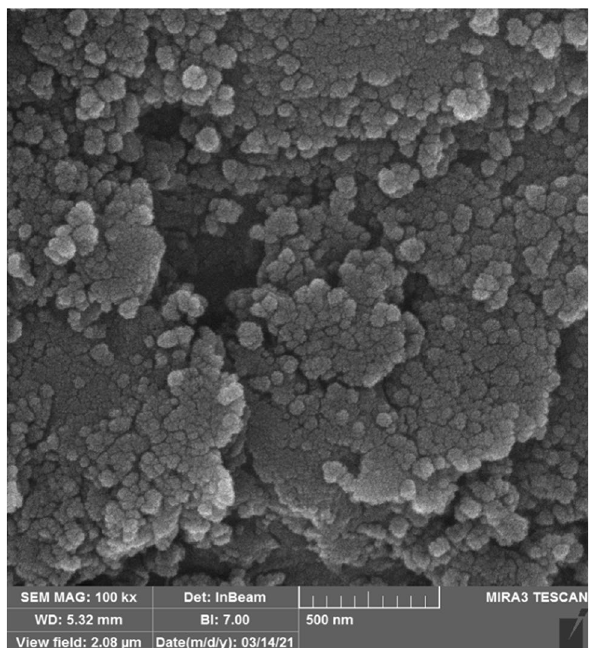
Figure 6. SEM image of Fe-Ben/PVP-DVB/Pd nanocatalyst.